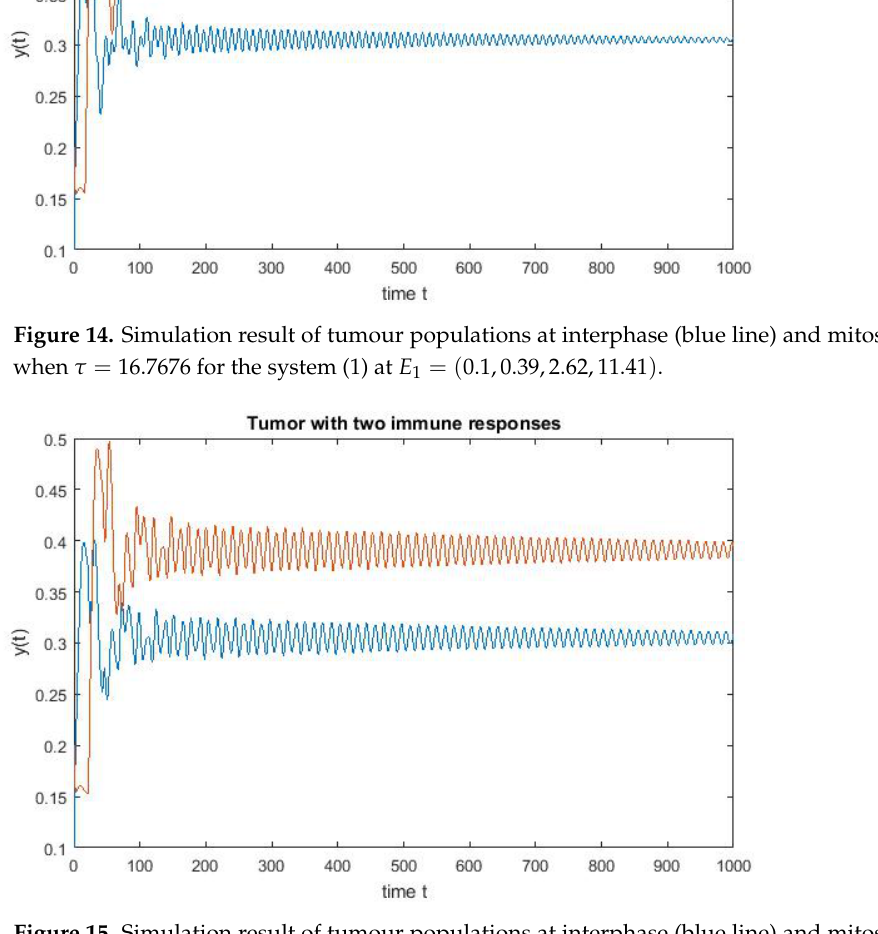
Figure 15. Simulation result of tumour populations at interphase (blue line) and mitosis (red line) when τ = 22.0586 for the system (1) at E 1 = ( 0.1,0.39,2.62,11.41 ) .